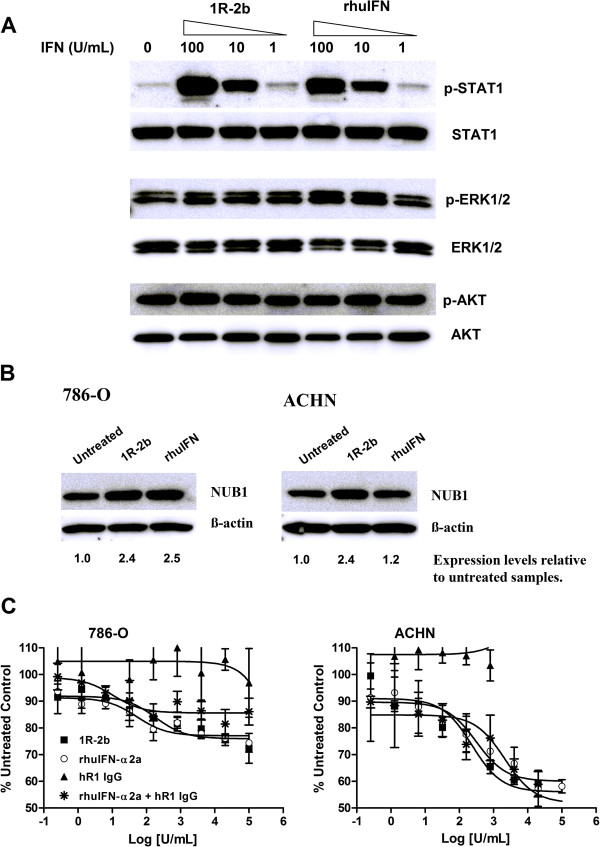
In vitro potency of 1R-2b. (A) IFN-α mediation of phosphorylation of STAT1, ERK1/2 and AKT in ACHN cells was performed as described in Materials and Methods. Cells were exposed to the indicated amounts of 1R-2b or rhIFN-α2a for 30 min (p-STAT1) or 60 min (p-ERK1/2 and p-AKT). Fold-increase in phosphorylation was calculated relative to total protein loading controls and normalized to untreated cells. (B) NUB1 expression was determined as described in Materials and Methods. ACHN or 786-O cells were exposed to 3000 U/mL of 1R-2b or rhIFN-α2a for 24 h. Up-regulation was determined relative to β-actin loading control and normalized against untreated cells. (C) Growth inhibition was performed as described in Materials and Methods in complete media containing 10% FBS. A dose/response curve was generated with 1R-2b or rhIFN-α2a ranging from 1×105 to 0.26 U/mL. Graphs show growth relative to untreated control and represent the mean ± standard deviation.